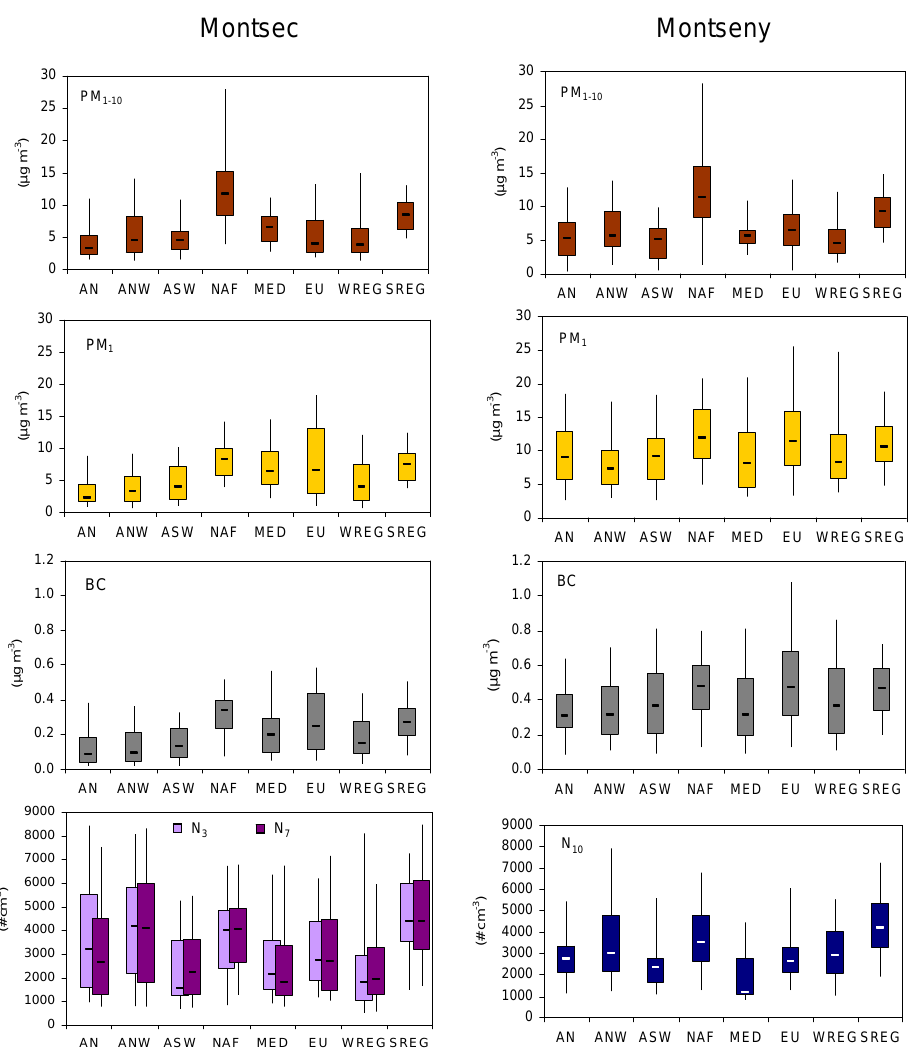
Fig. 4. Median (black line within the boxes) and percentiles (5-25-75-95, boxes and whiskers) of daily PM 1 − 10 , PM 1 , BC and N concentra- tions during the study period as a function of the air mass origin at Montsec and Montseny.